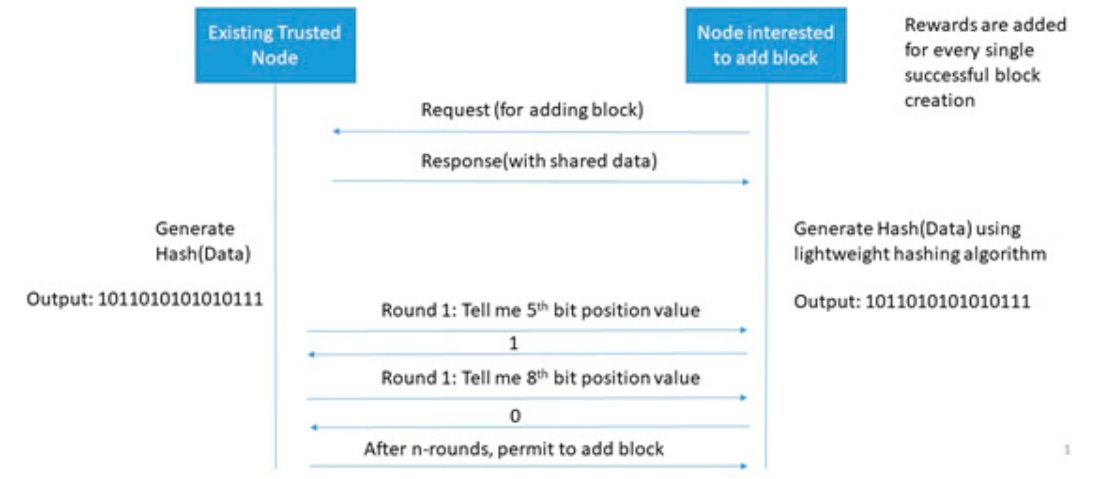
Figure 5. A proposed single-player single-bit PoG.